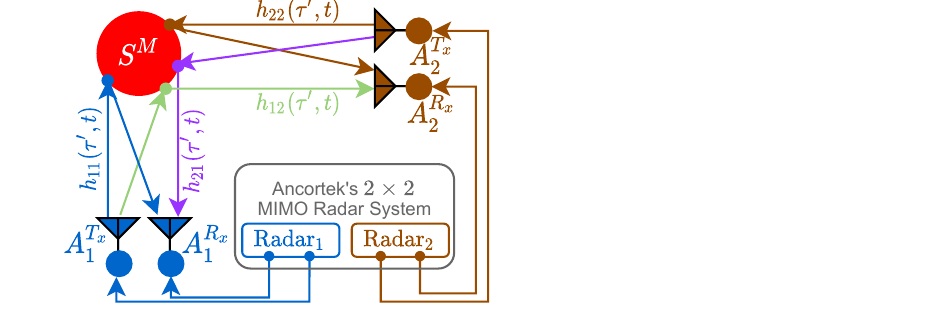
Figure 1. Two radar subsystems forming a 2 × 2 MIMO radar system in the presence of a single moving scatterer S M